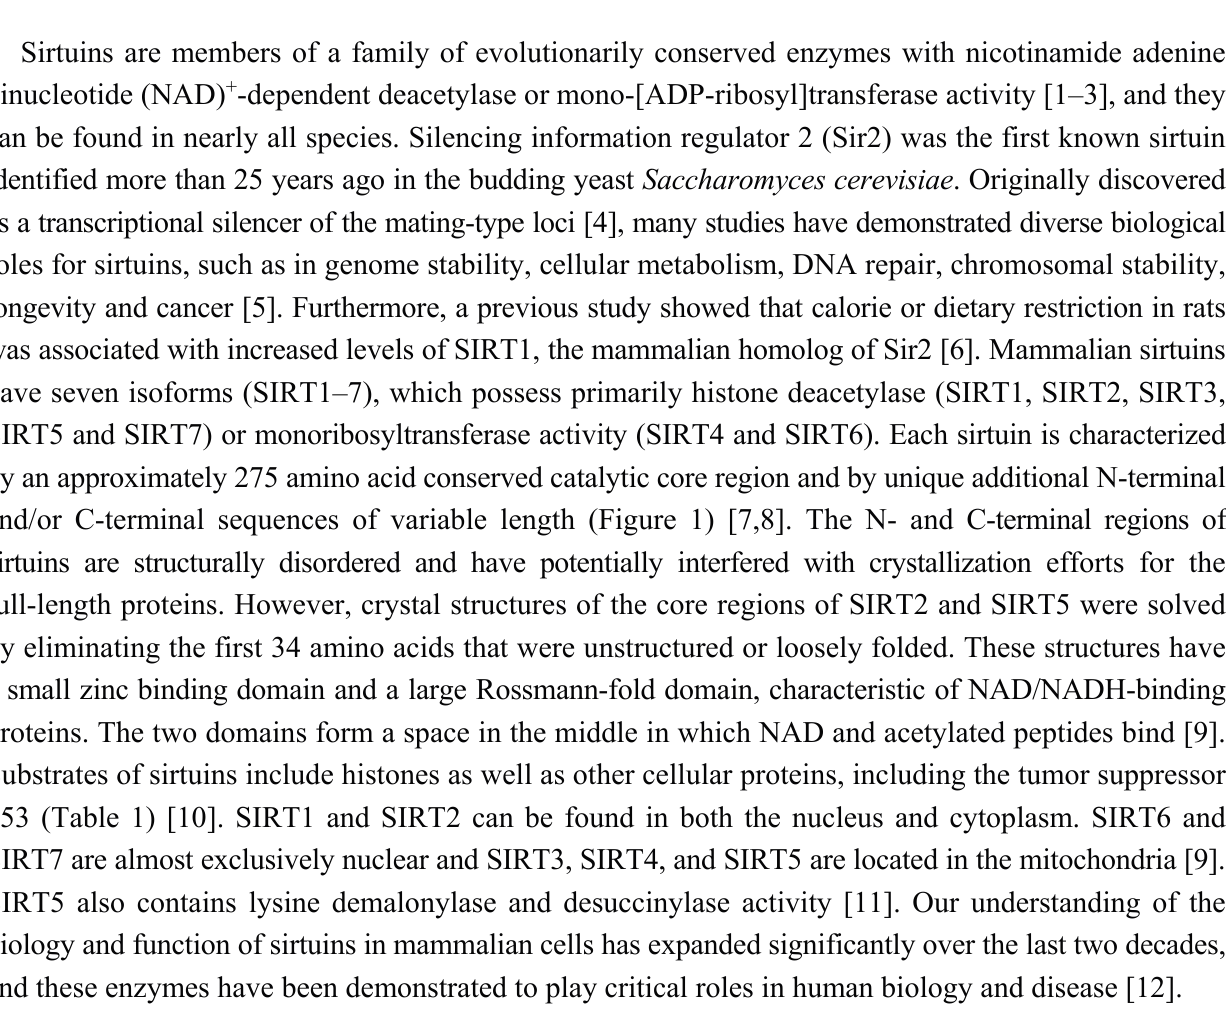
Figure 1. Schematic representation of human sirtuins. Sirtuins require NAD + as a cofactor to exert their function with NAD + dependent catalytic domain (dotted: blue) and zinc-binding domain (closed: